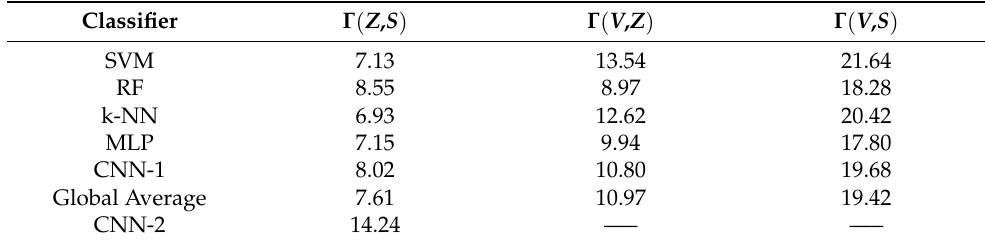
Table 4. Relative improvements in the accuracies listed in Table